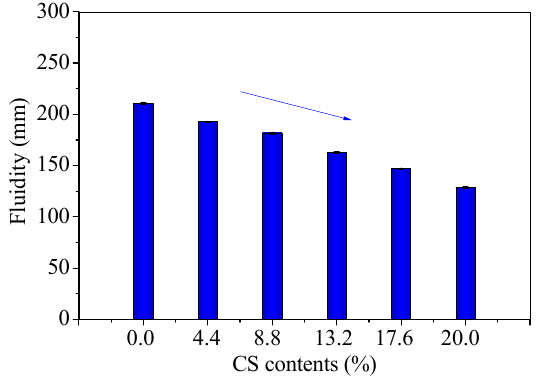
Figure 3. The fluidities of fresh CS–FA–GEO mixtures with different CS contents.